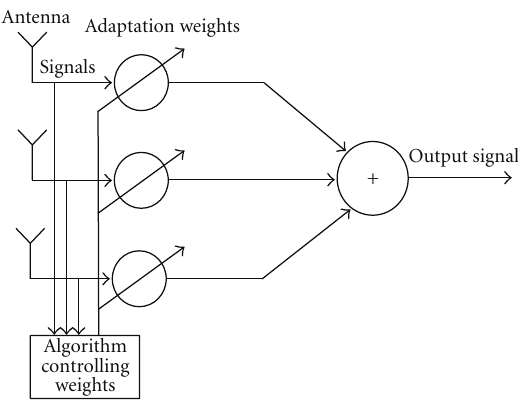
Figure 1: A simplified block schema of adaptation antenna system.